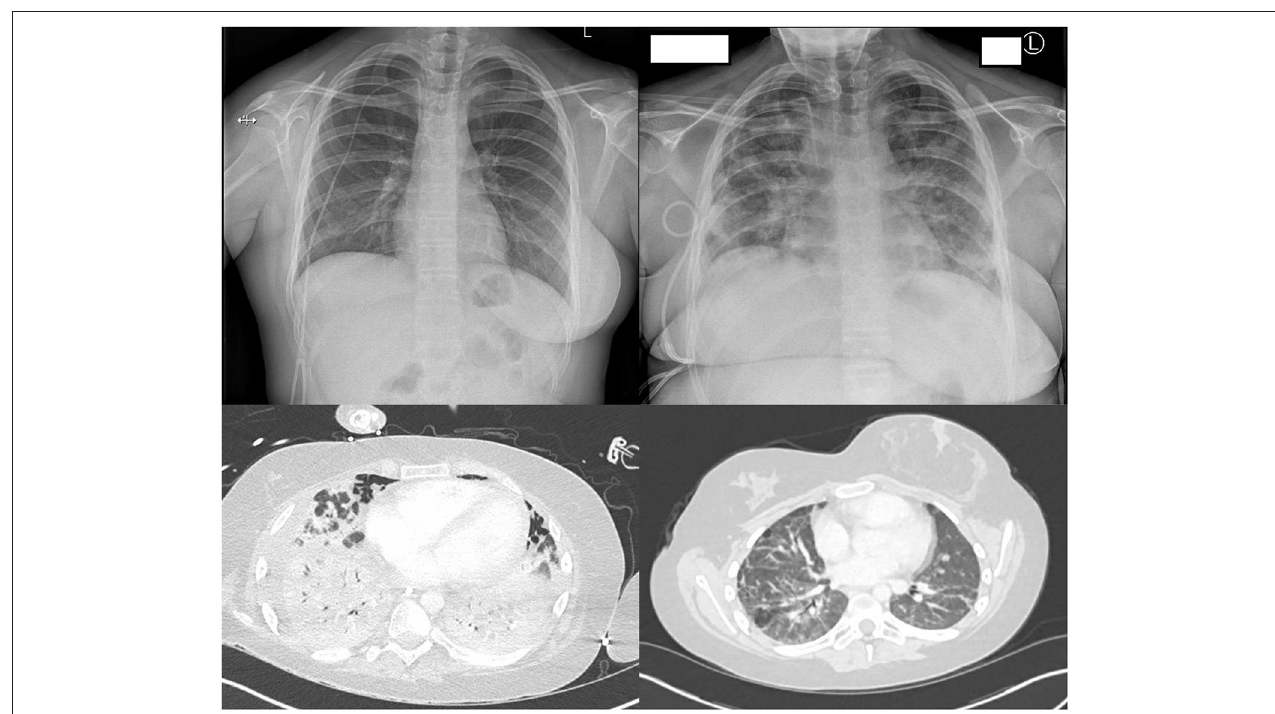
FIGURE 2 | Chest radiology during admission. Top left: Chest X-ray at baseline (Day − 1). Top right: Chest X-ray at ARDS development (Day + 10). Bottom left: CT thorax post-tracheostomy (Day + 47) showing extensive inflammation fitting with COVID-19. Bottom right: CT thorax 3 months post discharge showing residual lung